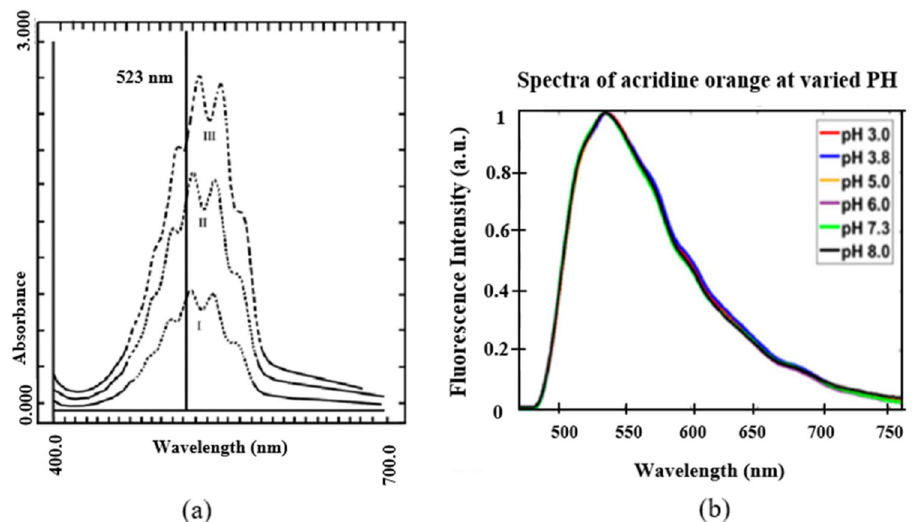
Figure 1. Emission spectra of substances: ( a ) standard potassium permanganate solution and ( b ) standard AO